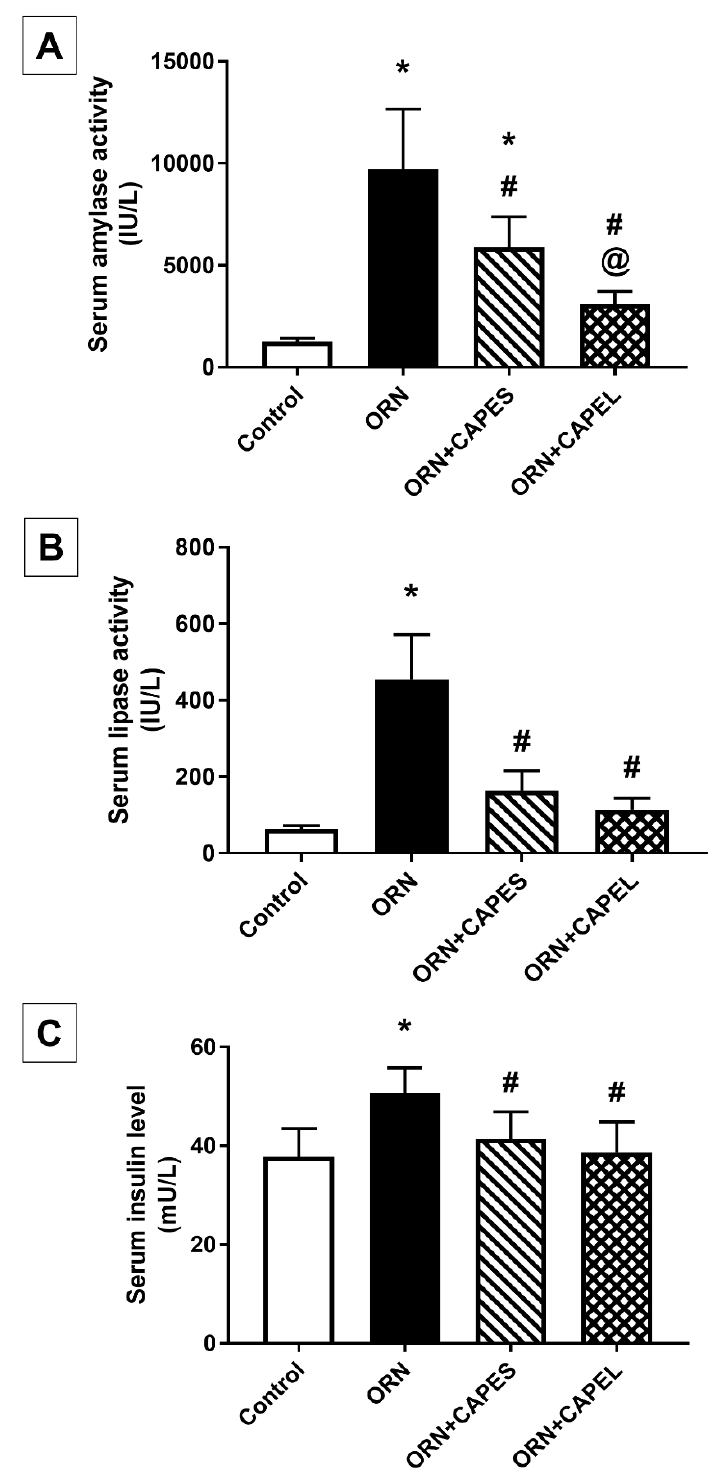
Figure 3. Effect of administering caffeic acid phenethyl ester (CAPE)-optimal liposomal formulation (CAPEL) on serum amylase and lipase activities and insulin level in rats with ornithine-induced acute pancreatitis. ( A ) Serum amylase activity. ( B ) Serum lipase activity. ( C ) Serum insulin level. Data are expressed as mean ± S.D. ( n = 8). *, # and @ indicate significant difference at p < 0.05 from control, ORN and ORN+CAPES groups, respectively (one-way ANOVA followed by Tukey’s multiple comparisons test). ORN, ornithine; CAPES, free caffeic acid phenethyl ester (CAPE) suspension; CAPEL, caffeic acid phenethyl ester (CAPE)-optimal liposomal formulation.